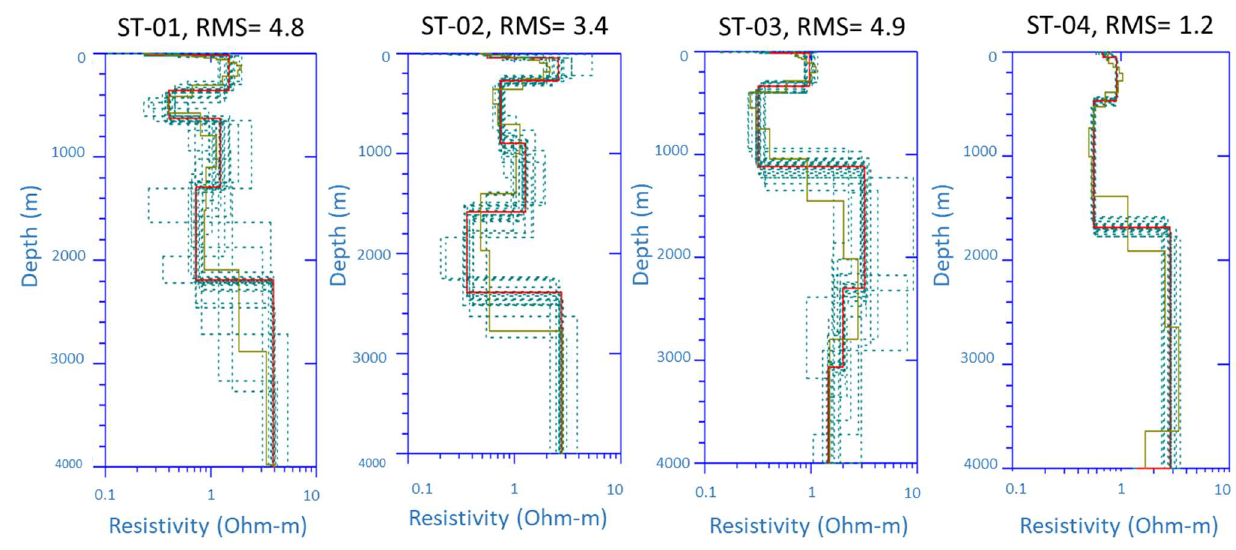
Figure 12. 1D inversion results for MT data in ST-01, ST-02, ST-03, and ST-04.